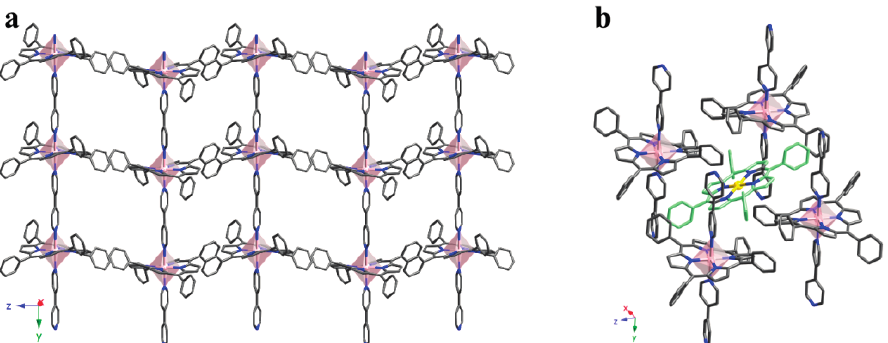
Figure 8. ( a ) View of the structure for compound 4 where the packing of the 1D polymers is observed; ( b ) Detail of the structure showing a single crystallization molecule of TPP connected to four 1D polymers through the π -bonding system. (Co(1): pink, Co(2): yellow, C: grey, N: dark blue and isolated porphyrin in green). H atoms have been omitted for